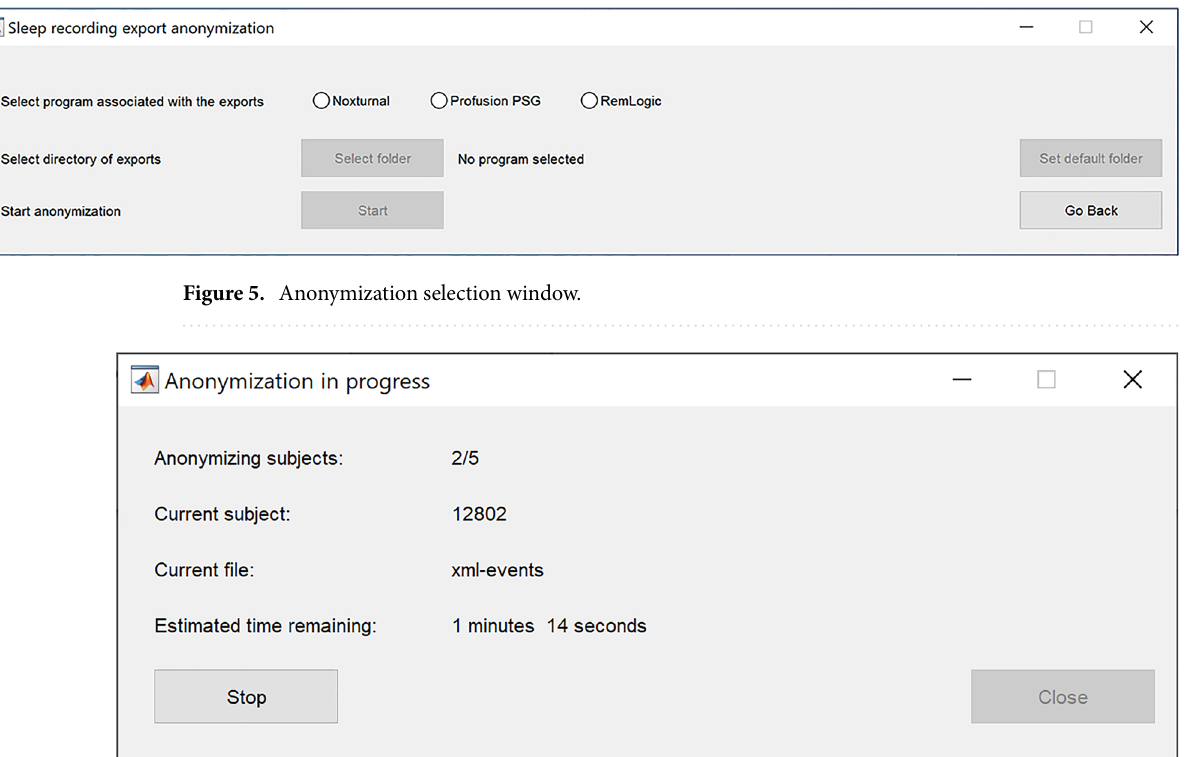
Figure 6. Anonymization